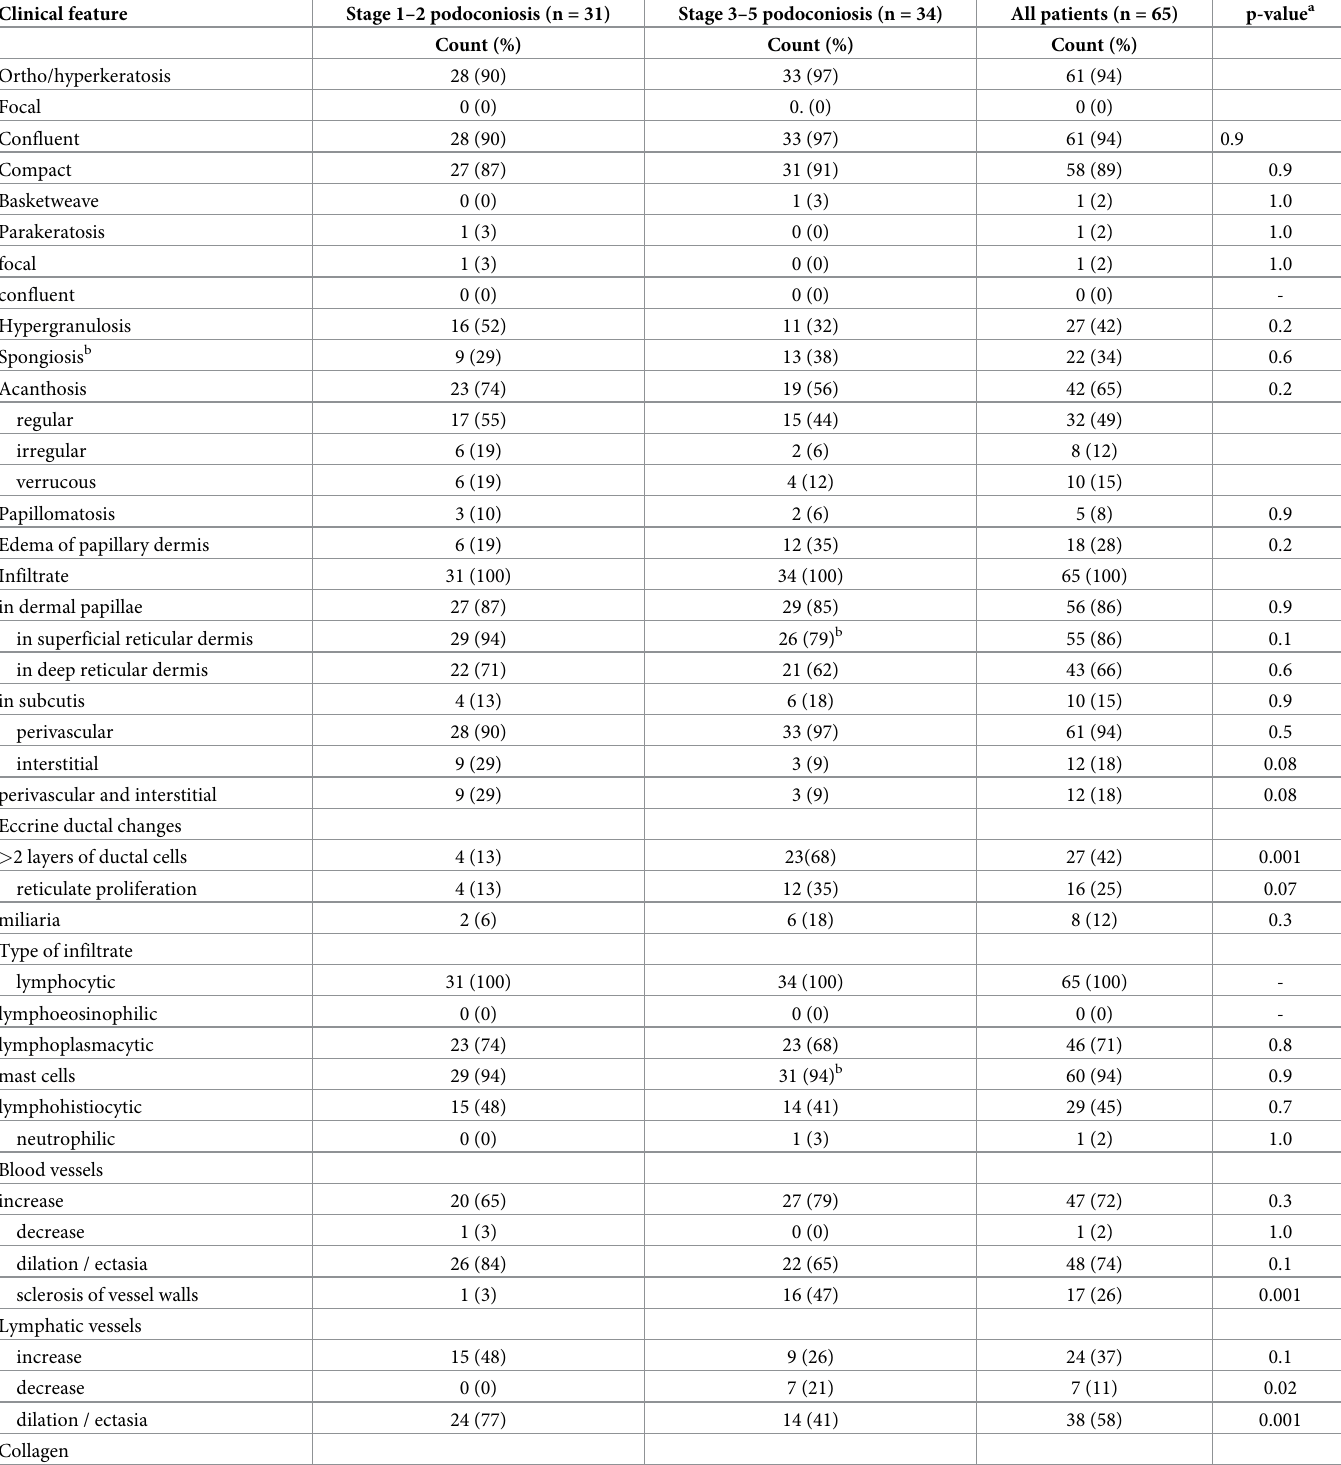
Table 4. Histopathologic findings and associations in skin biopsies from 65 patients with stage 1–2 versus stage 3–5 podoconiosis, in Durbete Podoconiosis Preven- tion and Treatment Centre, Durbete, Ethiopia, February 2018 to October